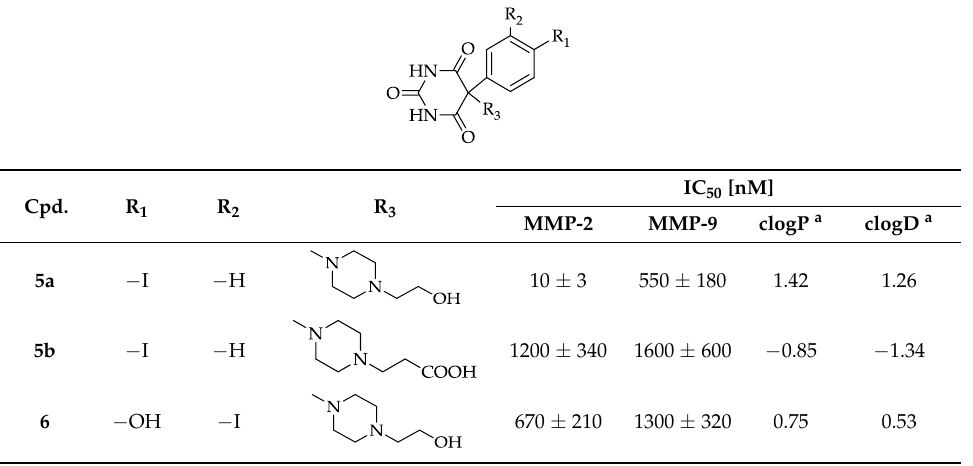
Table 2. Structures and IC 50 values of phenoxyphenyl barbiturates 9 – 12 . Cpd.